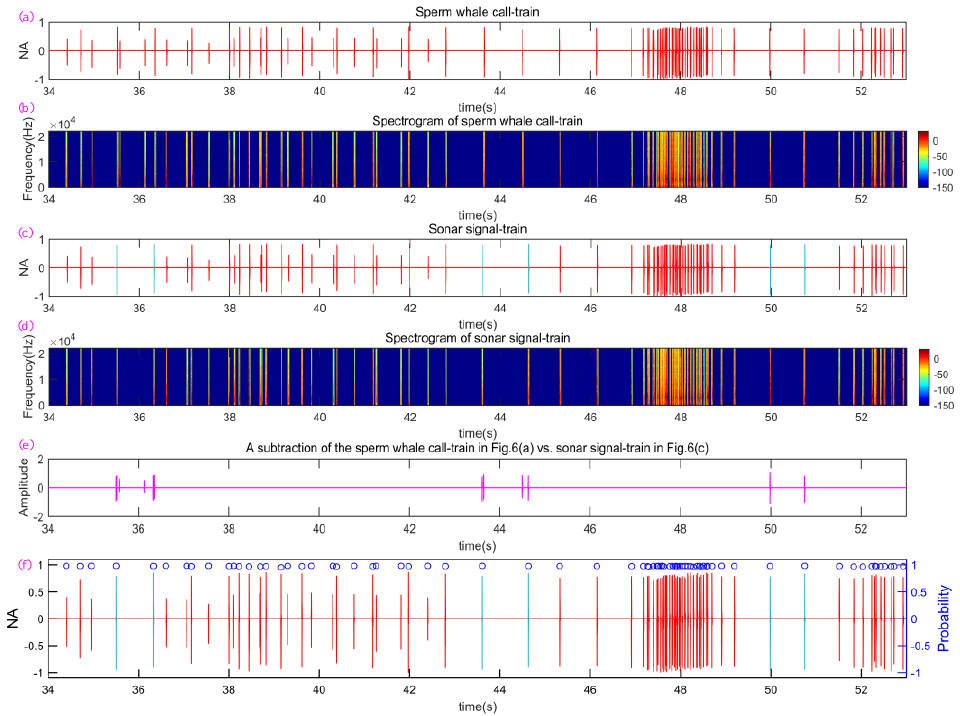
Figure 9. Comparison of waveform and spectrogram of both sperm whale call-train and sonar signal-train, and the results classified by NNBC. ( a ) A part of denoised sperm whale call-train from 34th to 53rd s; ( b ) the spectrogram of sperm whale call-train corresponding to ( a , c ) sonar signal-train embed by RVMC; ( d ) the spectrogram of sperm whale call-train corresponding to ( c , e ) a subtraction of the sperm whale call-train in Figure 9a vs. sonar signal-train in ( c , f ) the classification and recognition probability of sperm whale call pulses; the blue “o” denotes the probability that pulses are classified into sperm whale call ones.